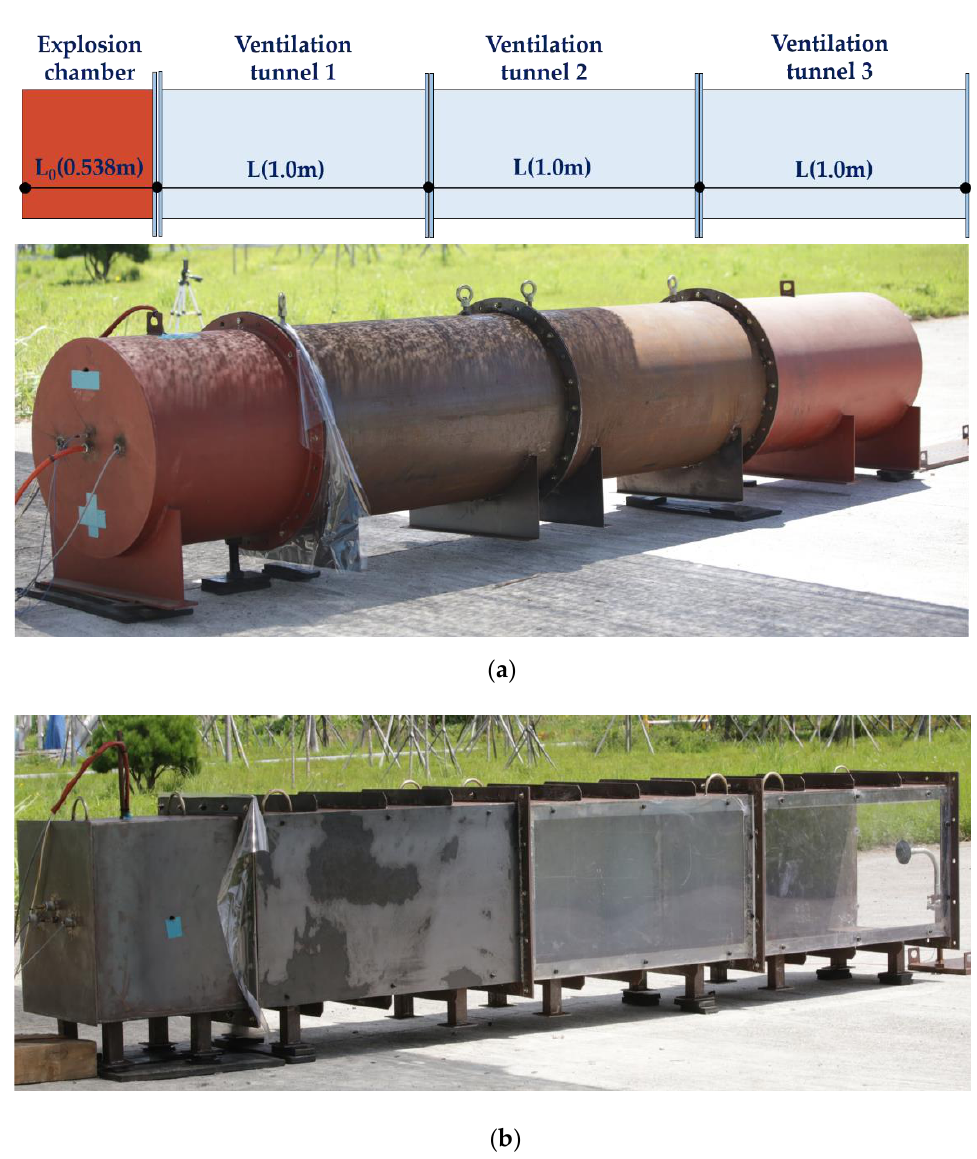
Figure 3. Photographs of a chamber and tunnel connected in cylinder- ( a ) and square- ( b ) types tunnel installation. Table 1. Specifications of the pressure